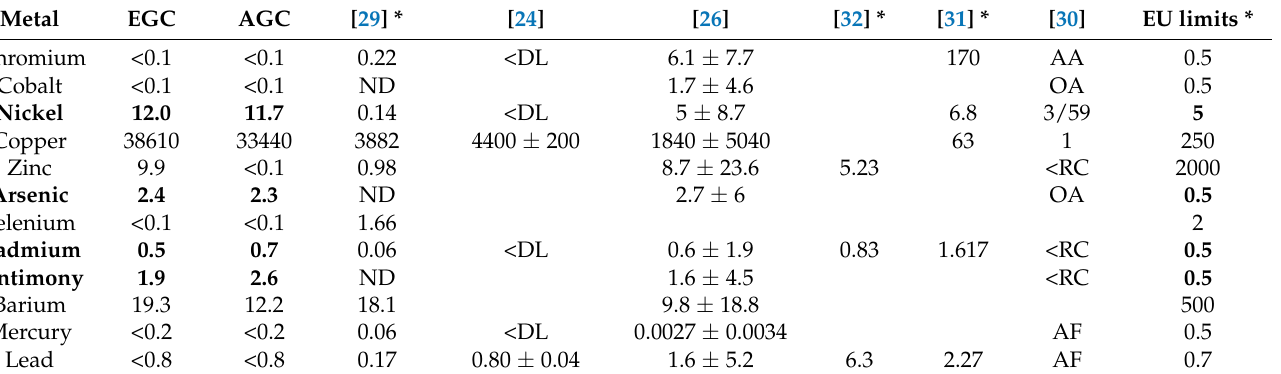
Table 1. Total concentration ( µ g/g) of various elements in EGC, AGC and reference papers, along with the limits recommended in the European Union. The elements marked in bold exceed or are very close to the limit indicated in the ResAP2008 and amendments. The star * indicates that data for the green ink were extracted from the reference paper. ND = not detected, DL = detection limit, RC = restricted concentrations; OA = element occasionally above the limit; AF = element present in a few inks; AA = element almost always